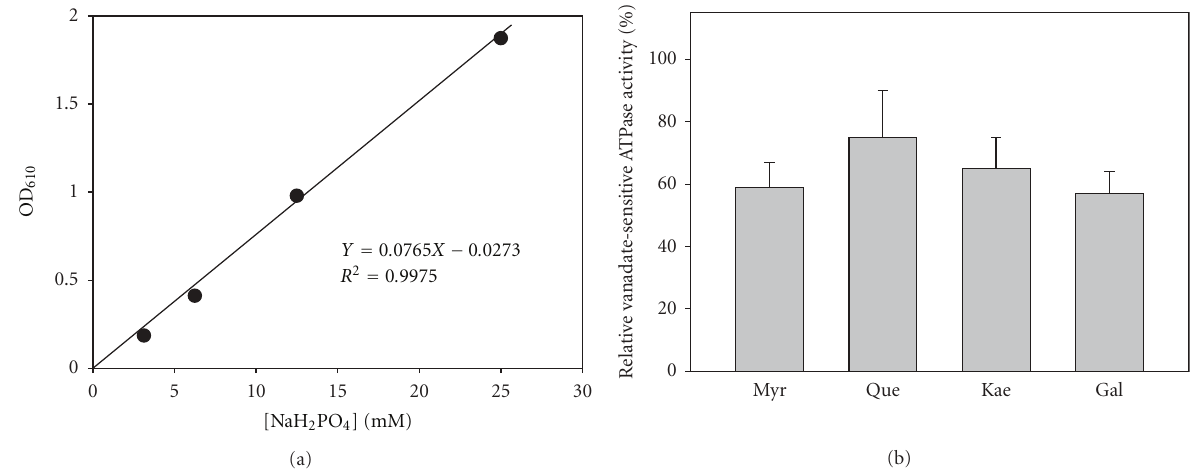
Figure 4: ssDNA-dependent ATPase activity of Kp DnaB. (a) The vanadate-sensitive colorimetric determination of inorganic phosphate released by the hydrolysis of ATP. A standard linear regression curve was generated by plotting the optical density (OD) at 610 nm against the concentrations of sodium phosphate (NaH 2 PO 4 ). (b) ATPase activity of Kp DnaB is inhibited by flavonols. In the presence of Myr, Que, Kae, or Gal, the specific activity of Kp DnaB was decreased to 59%, 75%, 65%, and 57%, respectively.